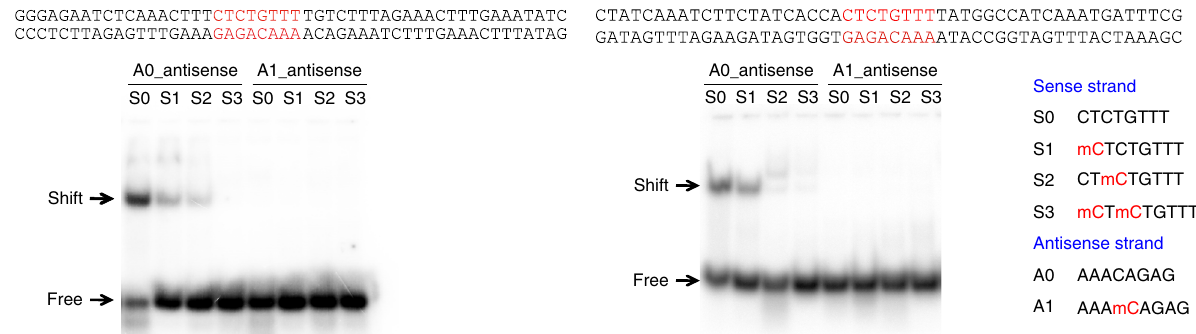
Fig. 3 Cytosine methylation decreases DNA-binding af fi nity of REF6-ZnF in vitro. EMSA with NAC004 ( AT1G02230 ) and AT4G11710 probes. REF6-ZnF speci fi cally bound the unmethylated probes, but had signi fi cantly lower (or no) af fi nity for probe sequences containing one or more methylated cytosines. Source data are provided as a Source Data fi le